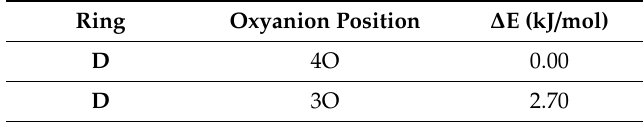
Table 3. EGCG anions relative energy calculated at B3LYP/6-31+G(d,p) level.